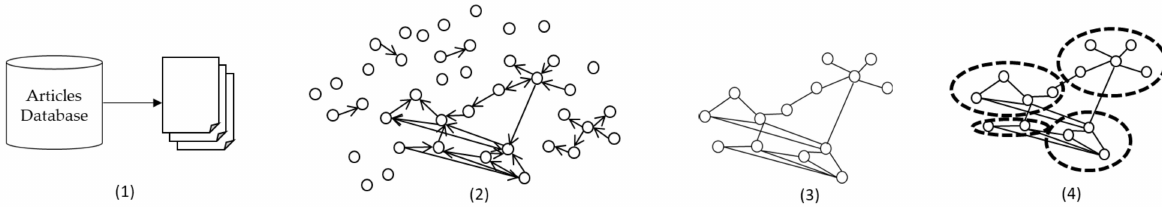
Figure 1. Method to create a direct citation network. ( 1 ) Data from extracted articles including reference list from the database; ( 2 ) establish a connection among articles based on citations; ( 3 ) extract the giant component; ( 4 )